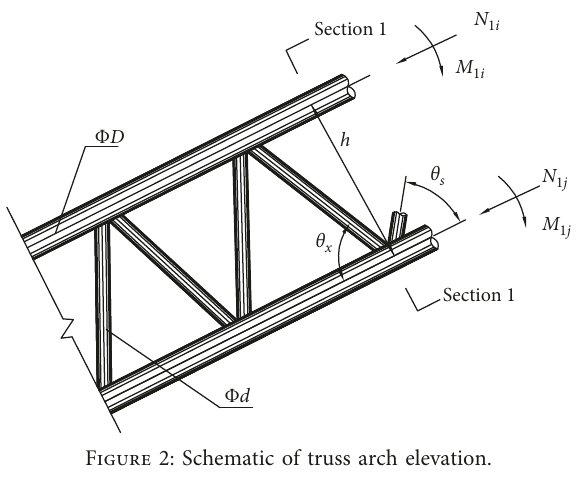
Figure 2: Schematic of truss arch